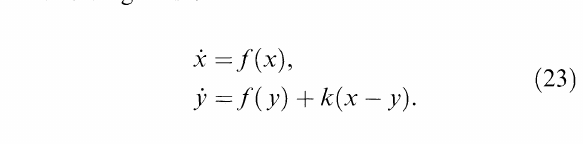
FIGURE 3 The bifurcation diagram showing state dij]br- ence z2 versus coupling coefficient k for coupled Duffing os- cillators (Eq. (27)) and estimated value of the largest Lyapunov exponent; d